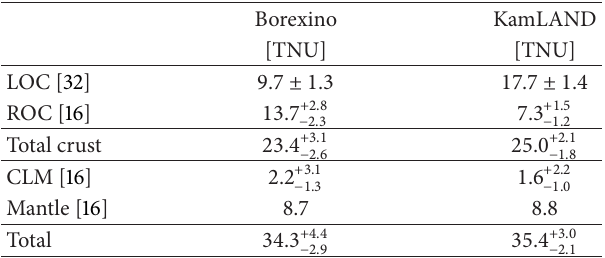
Table 1: Expected geo-neutrino signal in Borexino and KamLAND. Details in